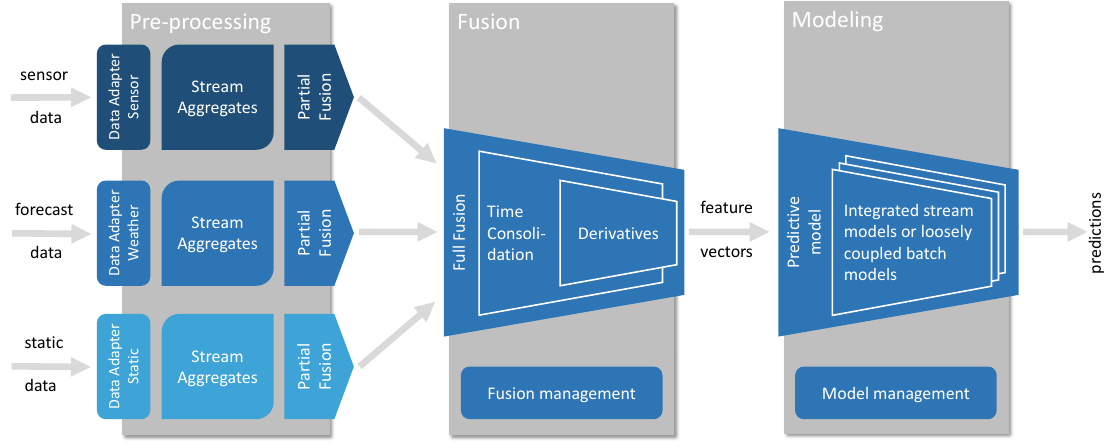
Figure 2. Data fusion framework architecture with added modeling component. The framework consists of three main components: pre-processing, fusion and modeling. Pre-processing is dedicated to the independent transformation of particular data streams, fusion merges them together into full feature vectors, whereas modeling provides predictions from either generated batch models or from incremental learning